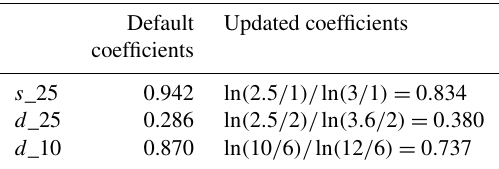
Table 3. Default and updated values of the s _25, d _25, and d _10 mapping coefficients used to calculate PM 2 . 5 and PM 10